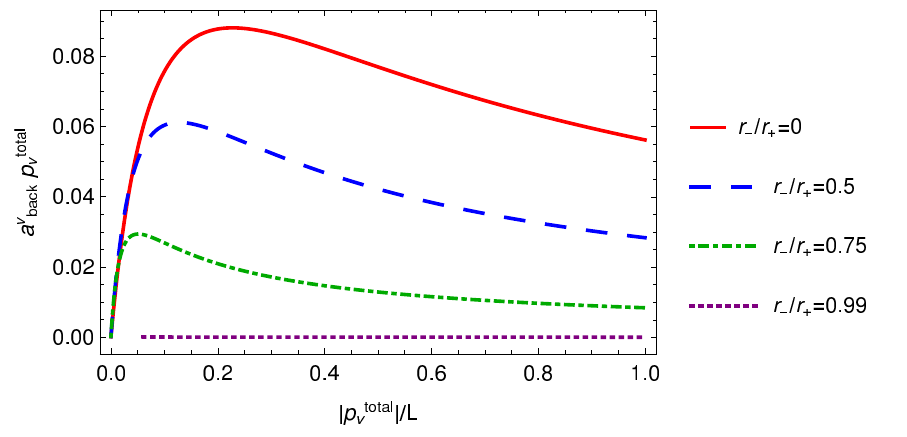
Figure 13 . Bound on information as we approach the extremal limit, (cid:12)xed M = 1. The dashed purple curve with J=M = : 99 shows that at extremality no information can be transferred. This is consistent with the wormhole closing in the extremal limit.